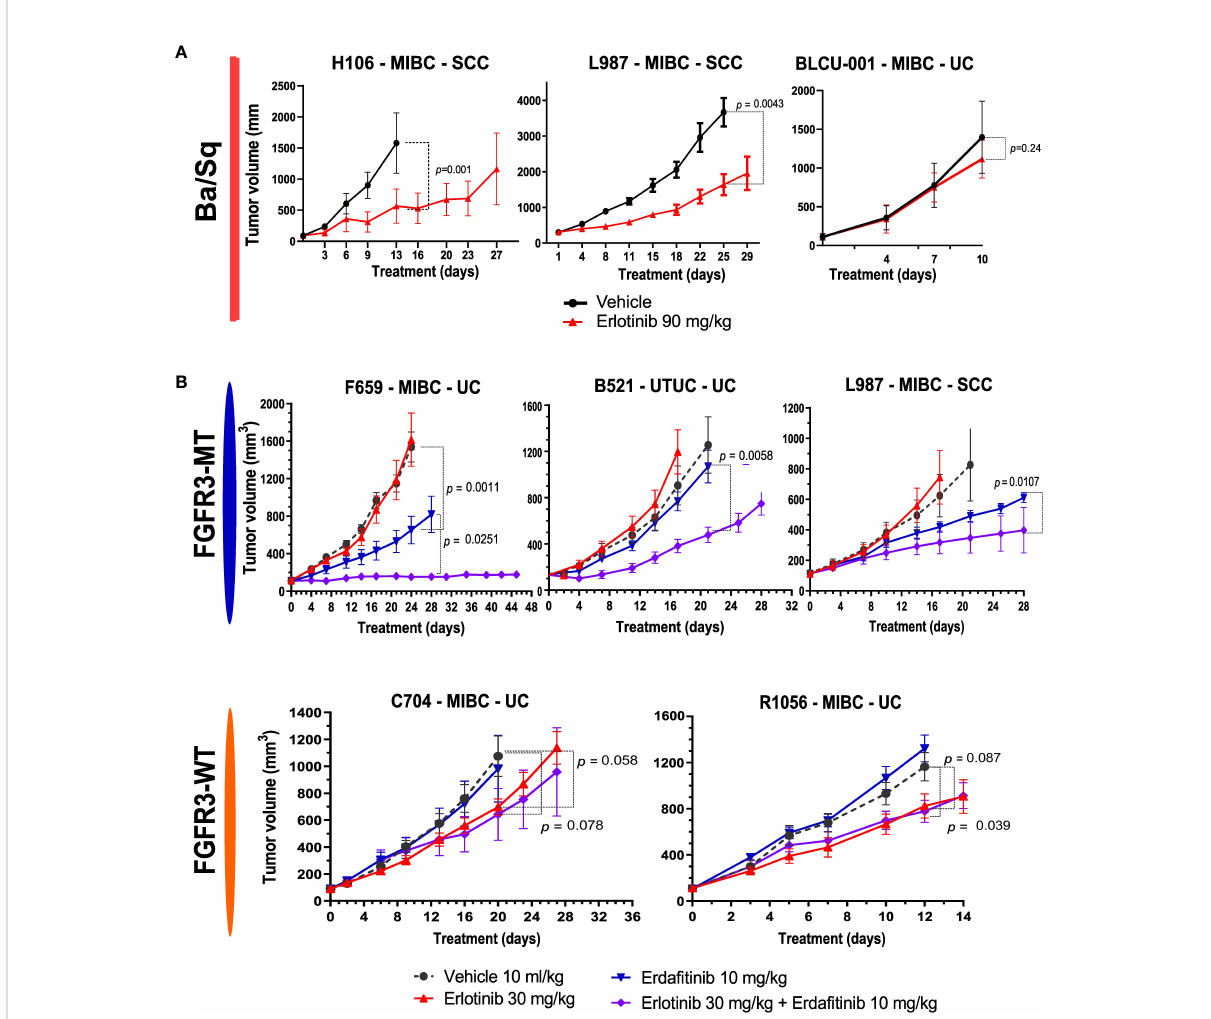
FIGURE 5 Sensitivity to anti-EGFR or the combination of EGFR and FGFR inhibitors in Ba/Sq and FGFR3 -mutated PDXs. (A) Mice with established basal/ squamous PDXs (67 – 270 mm 3 ) were treated with anti-EGFR (erlotinib 90 mg/kg, red) or control vehicle alone (black). (B) Mice with established FGFR3 -mutated tumors and controls were treated with control vehicle (black), low-dose anti-EGFR (erlotinib 30 mg/kg, red), a pan-FGFR inhibitor (erda fi tinib 10 mg/kg, blue), or the combination (purple), as indicated (n = 7 – 10 animals per group). Tumor size was measured at the indicated time points. Data are presented as mean ± SEM. Results were compared using the Mann – Whitney